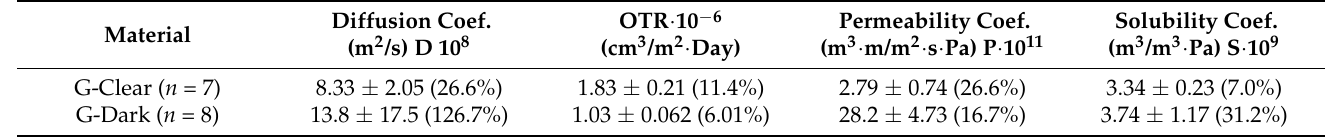
Table 14. Main permeation results of tested granite pieces in time lag mode.